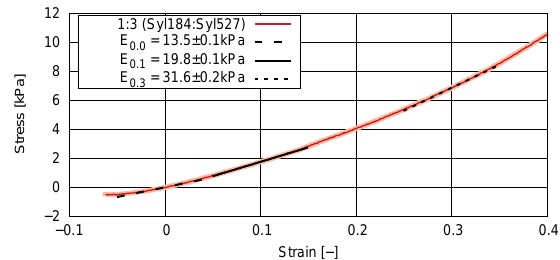
Figure 4. Deformation behaviour of 1 to 3 (Syl-